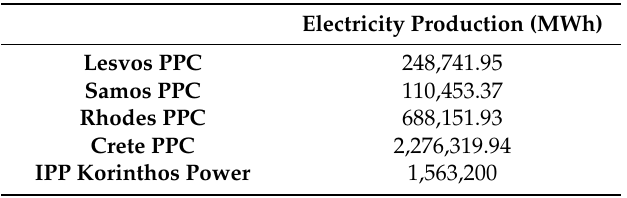
Table 3. Electricity Production 2016 (Conventional Power Plants) [18,19].